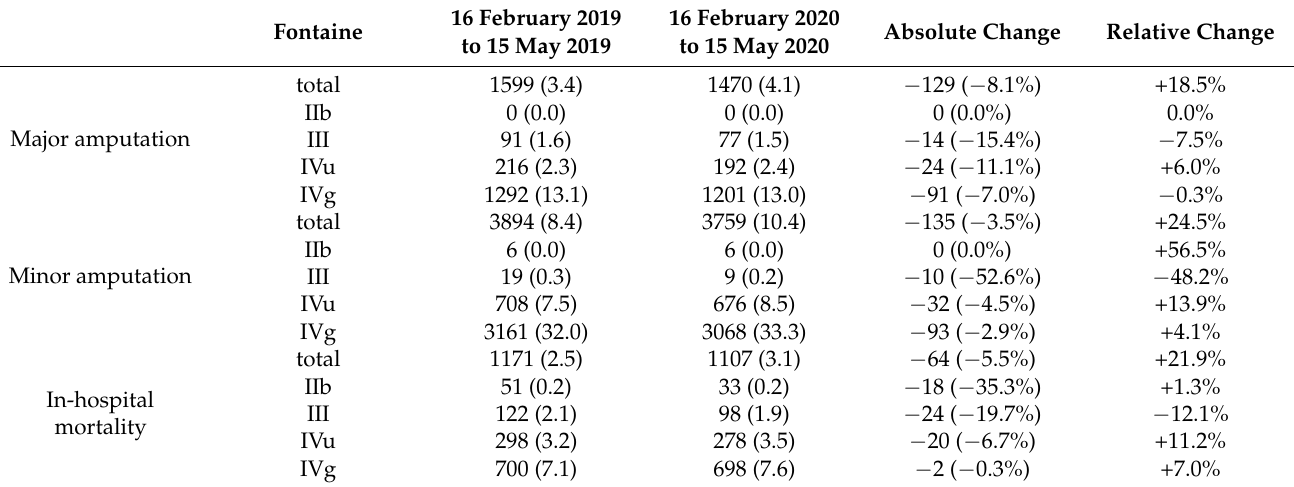
Table 4. In-hospital outcome of patients admitted due to peripheral artery disease from mid-February to mid-May in 2019 and